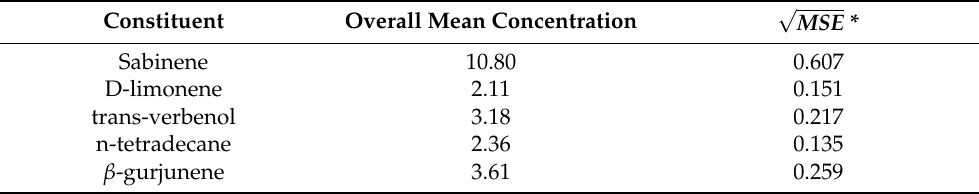
Table 4. Overall mean H. arenarium concentration (%) of sabinene, D-limonene, trans-verbenol, n-tetradecane and β -gurjunene where there was no significant difference among the three